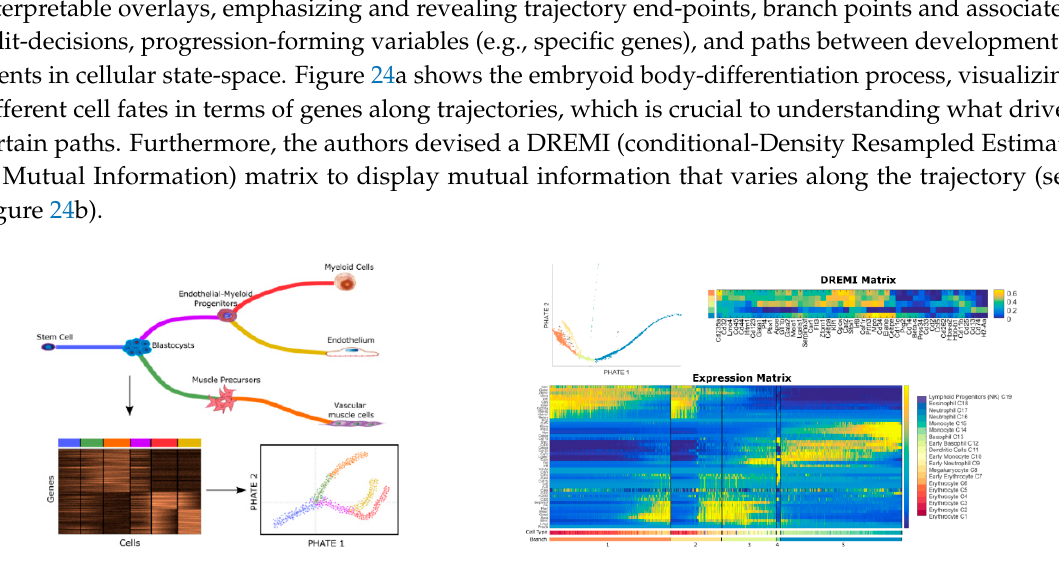
( b ) Figure 25. ( a ) Various projection modes [74]; and ( b ) inverse projection workflow [73].